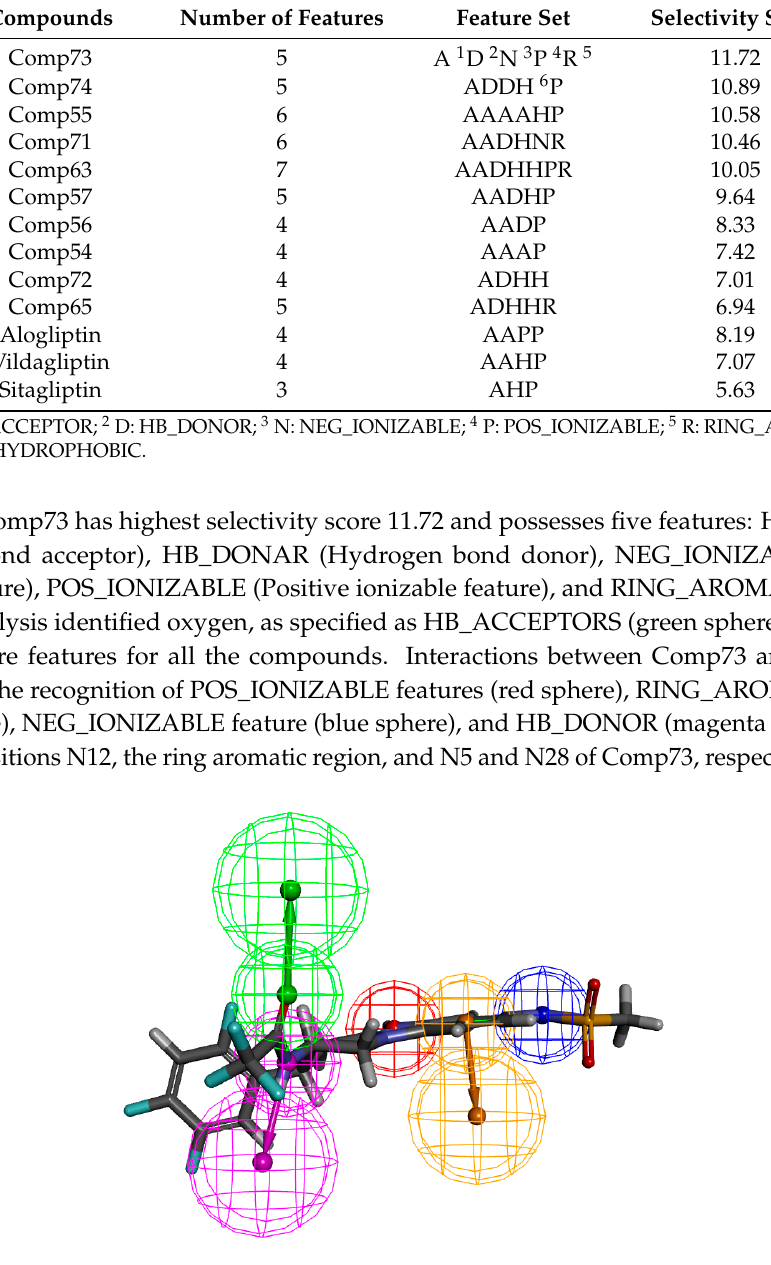
Figure 5. The result of pharmacophore features of 2P8S_Comp73 based on Receptor-Ligand Pharmacophore Generation. The hydrogen bond acceptor, hydrogen bond donor, positive ionizable feature, aromatic ring, and negative ionizable features are shown as green, magenta, red, orange, and blue, respectively.